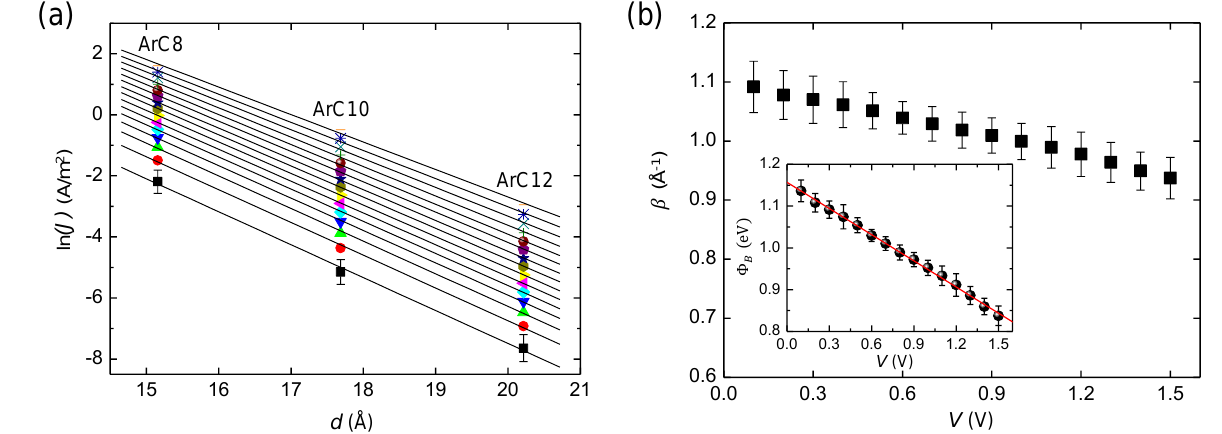
Figure 3. ( a ) Plot of ln( J ) versus d for the bias range from 0.1 (bottom) to 1.5 V (top). For clarity, the data only at 0.1 V contain the error bar, indicating the standard deviation upon averaging the current density. The β values were determined from the slope of the linear fits (solid line). ( b ) Plot of β versus V . The inset shows the bias-voltage dependence of the barrier height. The solid line indicates the linear fit.